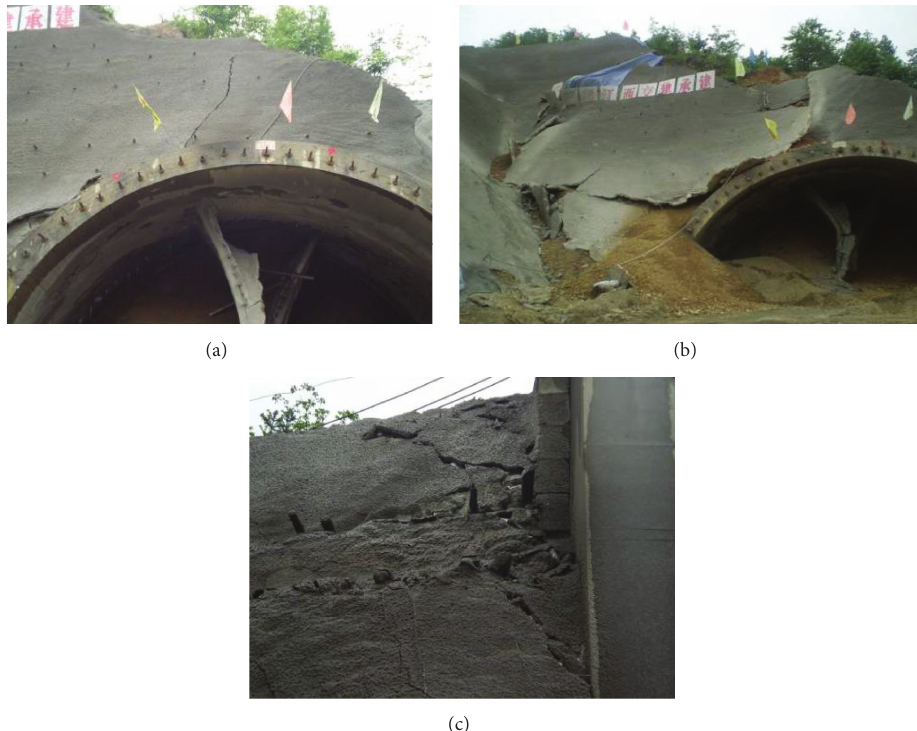
Figure 11: Damage in Ruipo tunnel portal: (a) cracks in slope at the beginning; (b) cracks expanded and instability of the slope; (c) cracks in landfills behind the antislide pile.